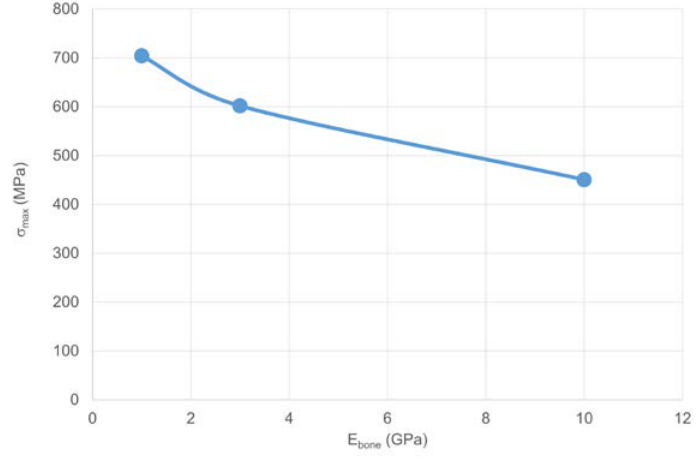
Figure 15. Index finger implant in proximal bone: ( a ) cut view of maximal principal stress in the implant; ( b ) Cut view of von Mises equivalent stress in the bone.